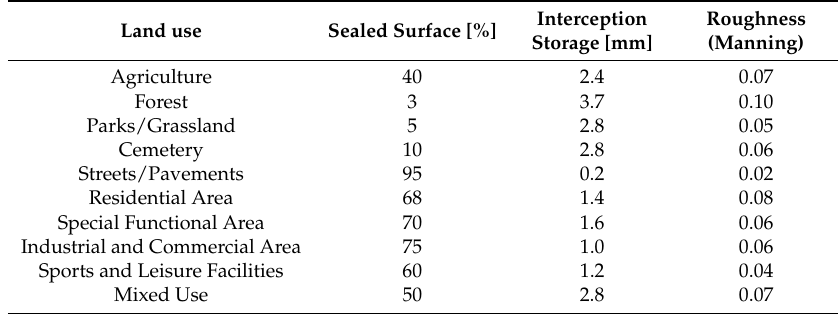
Table 2. Hydrologic-Hydraulic Modeling Parameters Used